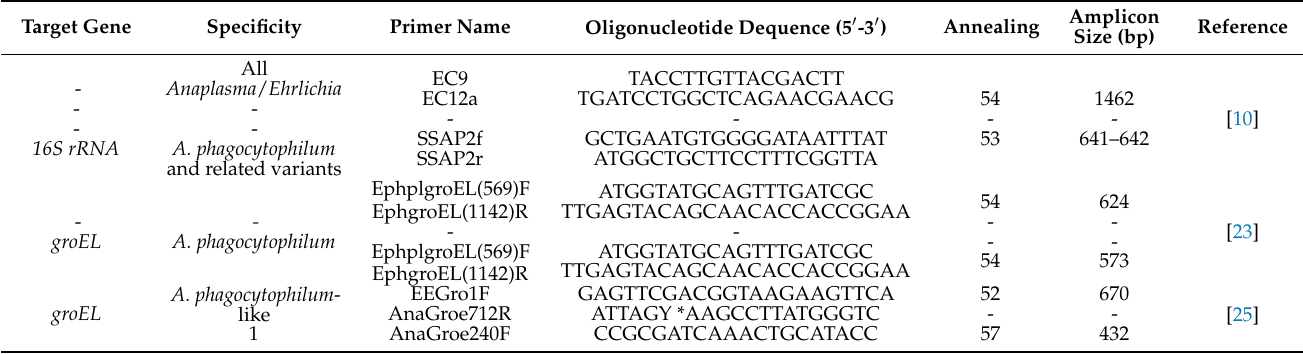
Table 1. Oligonucleotide primers used in this study (* Degenerate primer: Y = C or T). Target Gene